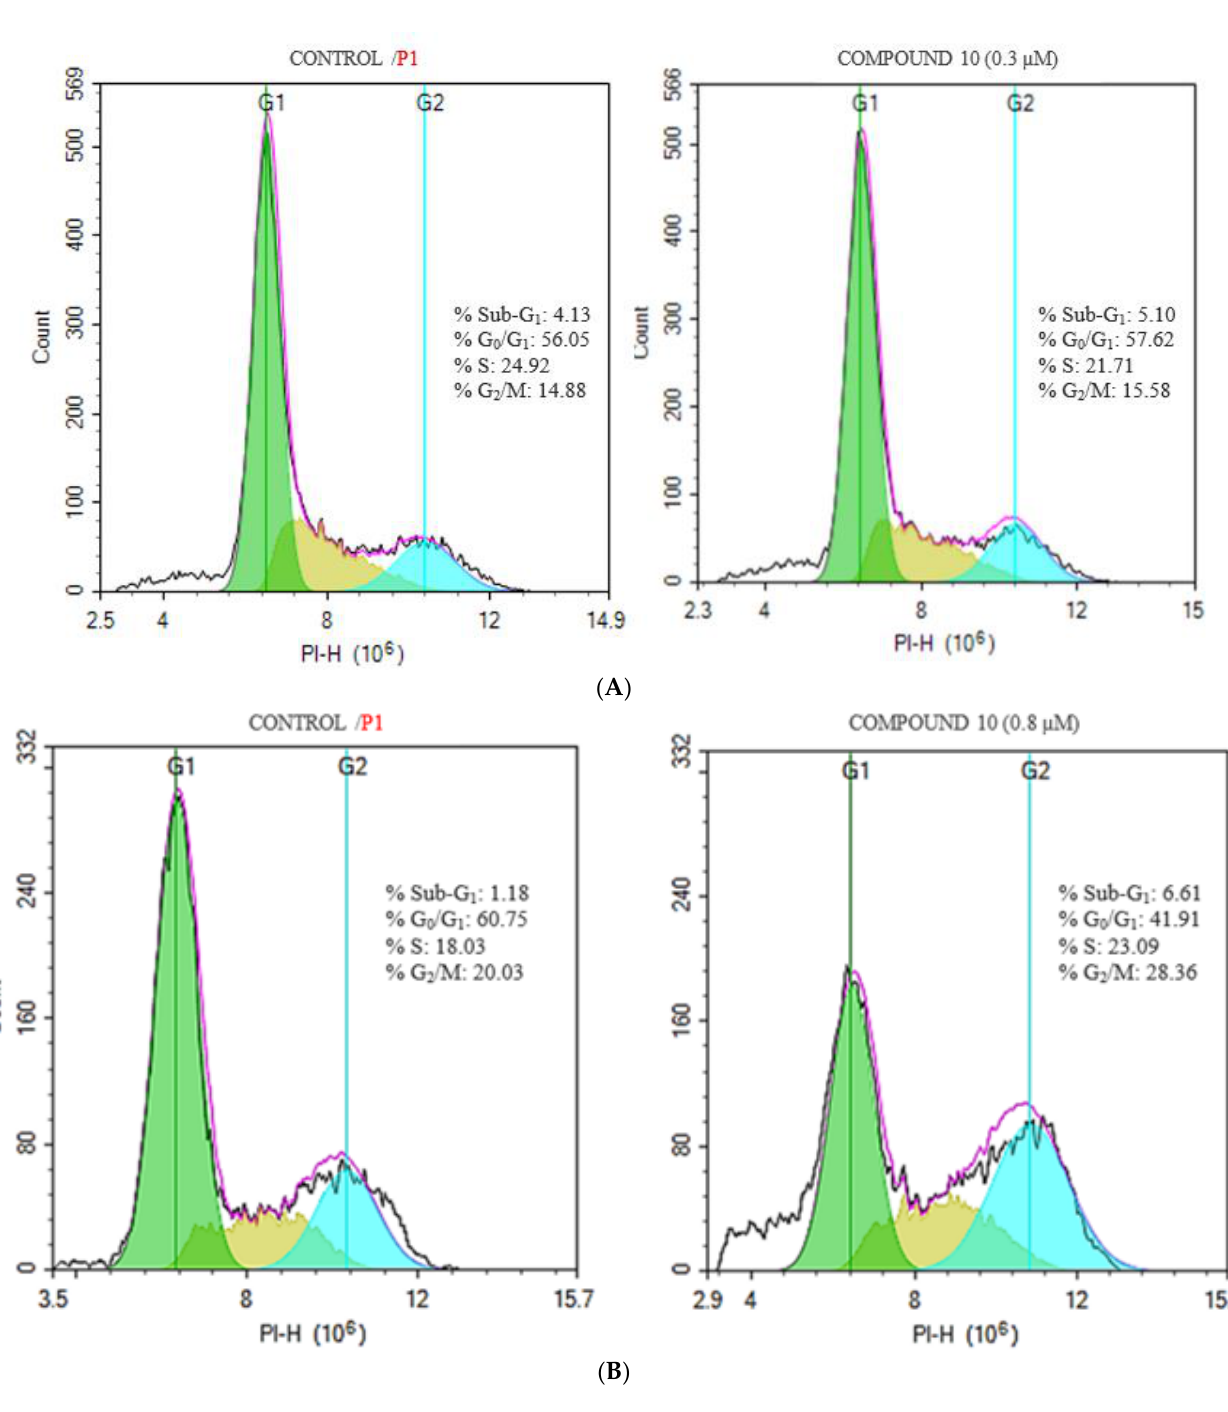
Figure 2. Representative histograms of the effects of compound 10 on cell cycle phase distribution of NCI-H460 ( A ) and OVCAR-8 ( B ) cell lines compared to control untreated cells. Permeabilized cells were stained with PI. Cell DNA content was assessed by flow cytometry. Inset data are the mean of three independent assays. Values were analyzed from at least 10,000 total events (see Section 2 for more details).